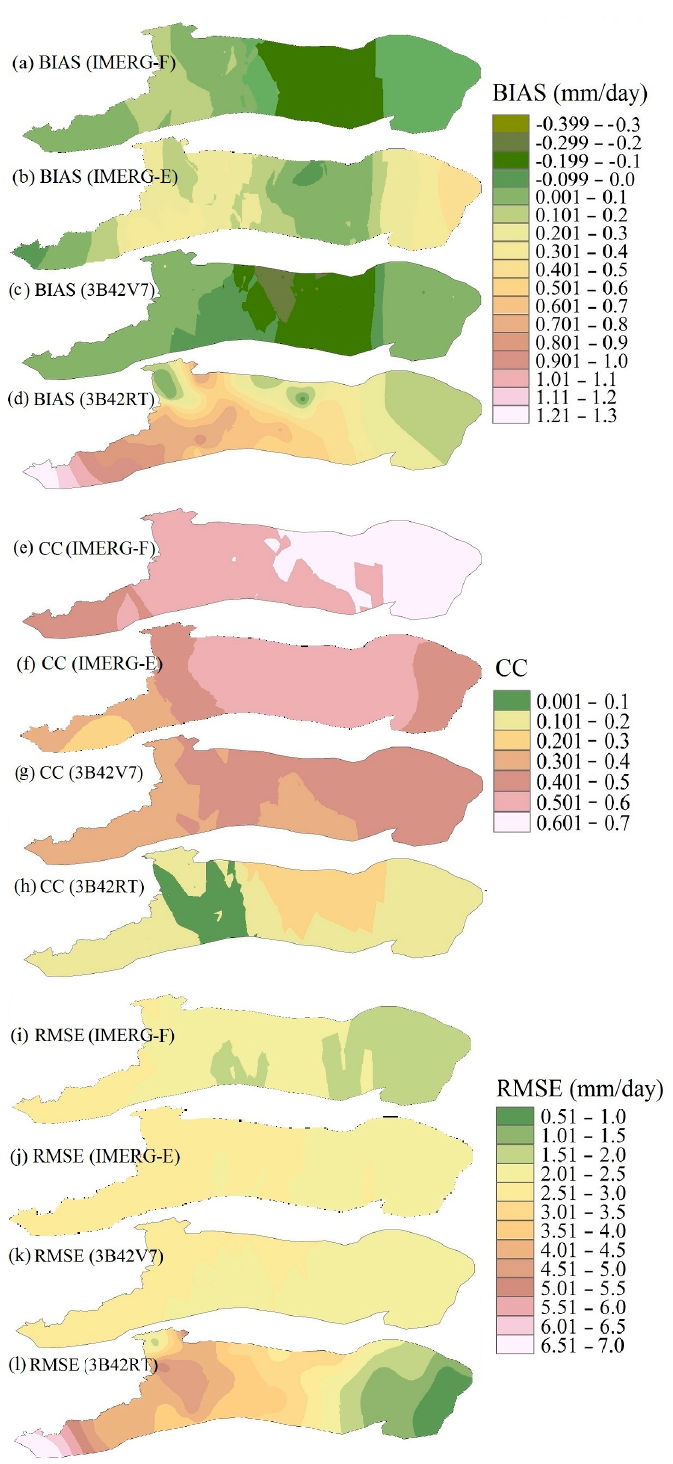
Figure 5. Spatial distribution of Bias ( a – d ), CC ( e – h ) and RMSE ( i – l ) of IMERG-E, IMERG-F, 3B42V7 and 3B42RT products against the reference data during April 2014 to October 2017.